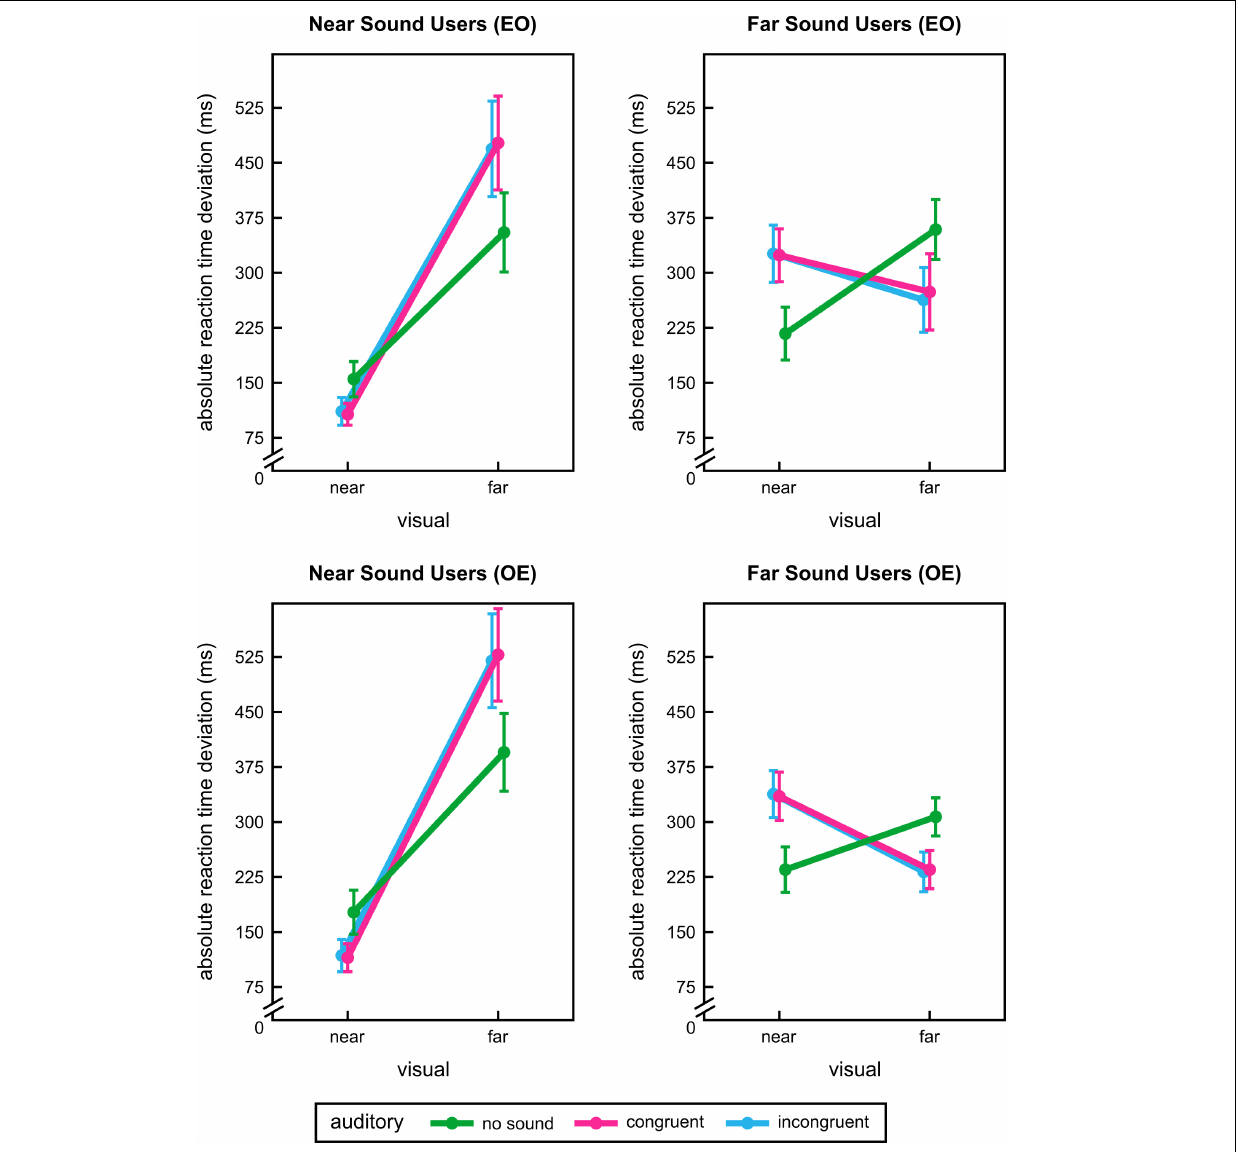
FIGURE 5 | User group results of the exploratory analysis of interindividual differences in experiment 2. Absolute reaction time deviations for each visual and sound conditions during extrapolation for different user groups. Results for near sound users (left panel) and far sound users (right panel) are shown. Near sound users profited from additional sound information at near extrapolation distances, far sound users at far distances. For details of user group segregation see main text. Analyses were conducted twice using a split-half technique: even blocks were used for categorising participants and odd block for analysing data (EO, upper panel) or odd blocks for categorising and even ones for analysing (OE, lower panel). Error bars show the standard error of the mean. Points are offset horizontally so that all error bars are